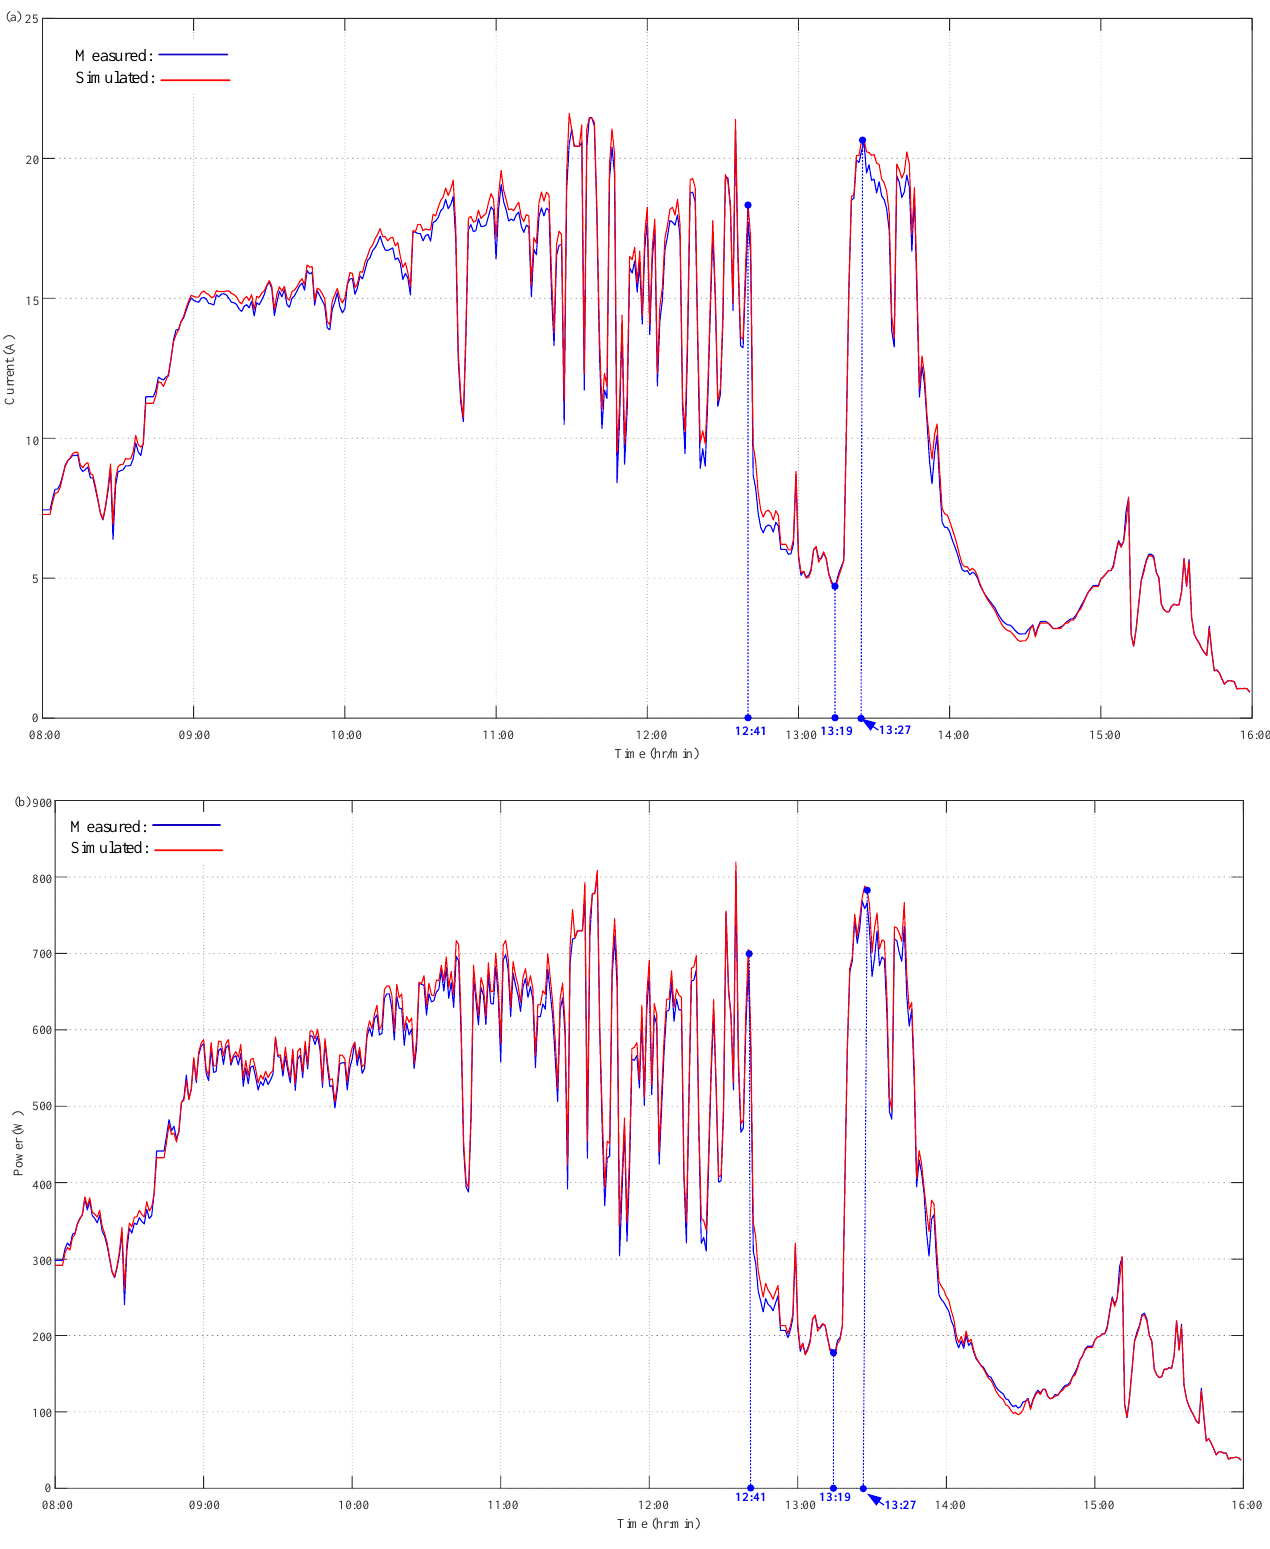
Figure 7. Simulated and measured results of PVEFD system: ( a ) output current; ( b ) output power.